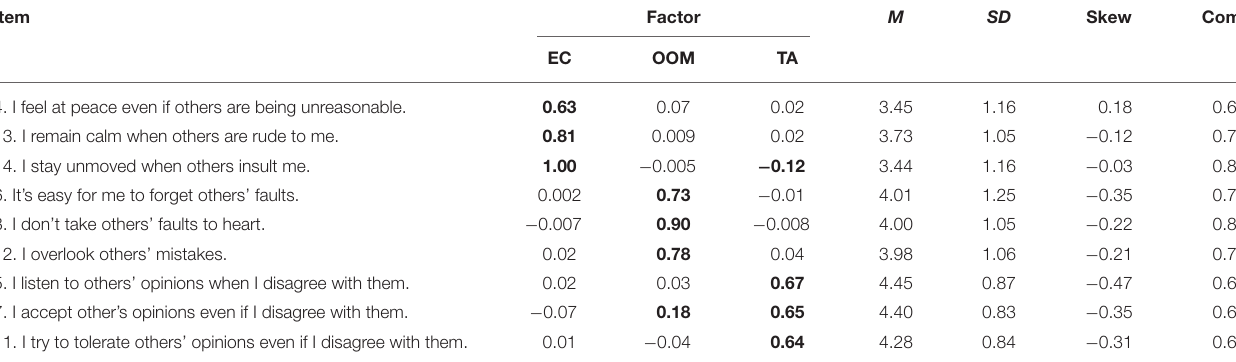
TABLE 5 | Exploratory factor analysis item loadings from pattern matrix, mean, standard deviation, skewness, and communality estimates for three-factor FS-SF 9. Item